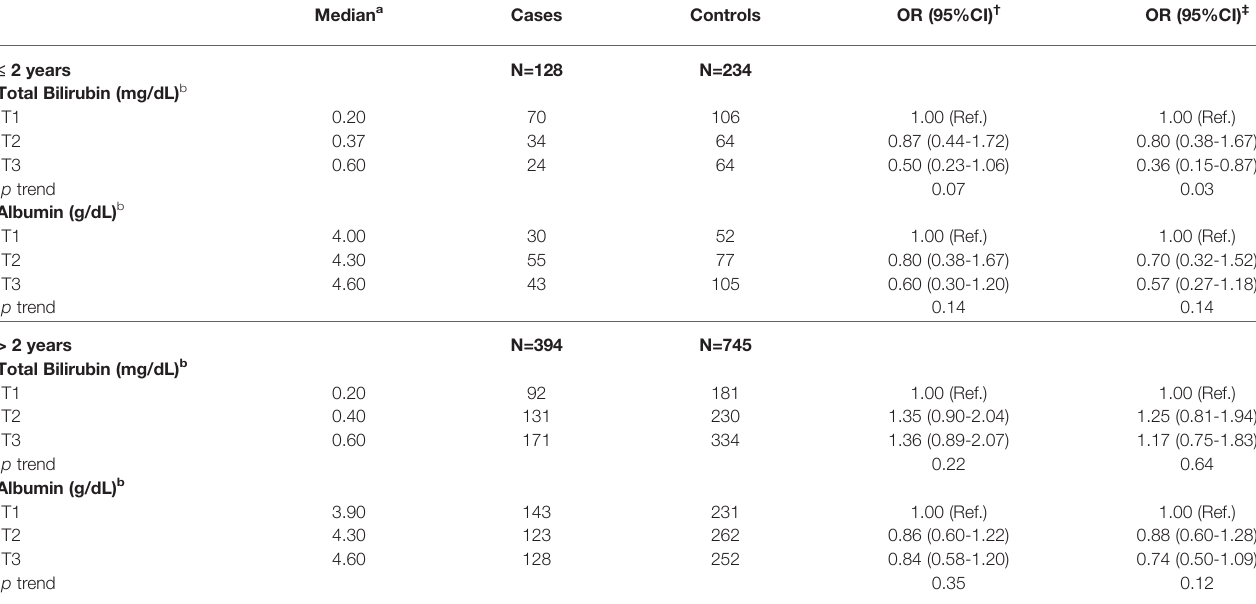
TABLE 3 | Association of serum levels of total bilirubin and albumin with lung cancer risk by time between blood collection and lung cancer diagnosis. Median a Cases